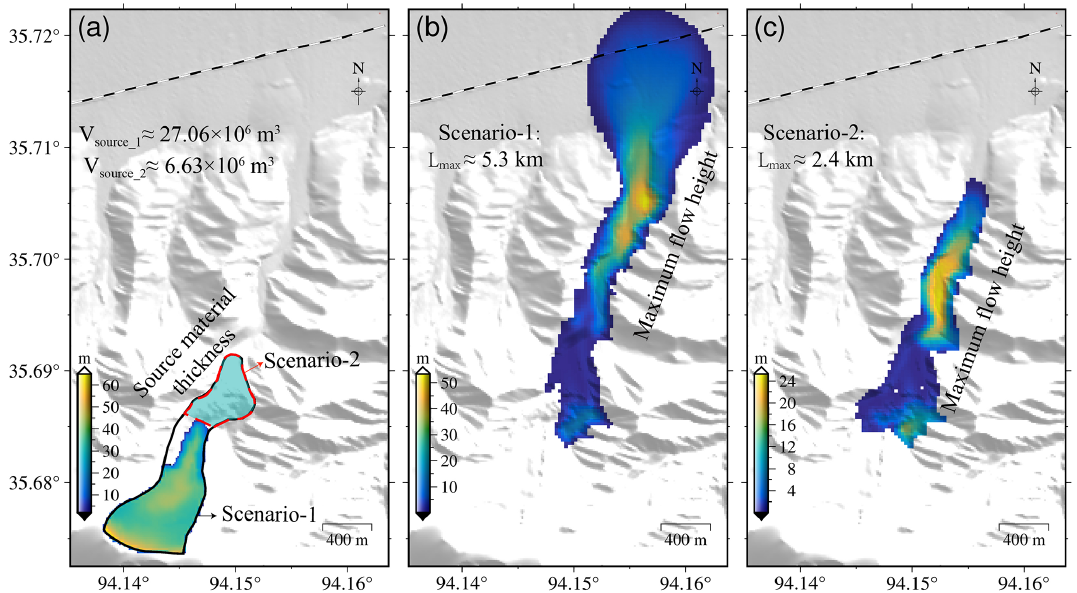
Figure 10. Runout estimates for the detachments of the whole glacier (scenario 1) and glacier tongue (scenario 2). (a) Ice (i.e., source material) thickness distribution of avalanche scenario 1 (black polygon) and scenario 2 (red polygon) derived from the global glacier ice thickness products of Farinotti et al. (2019). (b) The simulated maximum flow height of the avalanche for scenario 1 when choosing moderate friction values of 0.15 for Coulomb friction ( µ ) and 2500ms − 2 for turbulent friction ( ξ ) in the Voellmy–Salm model. (c) The simulated results for scenario